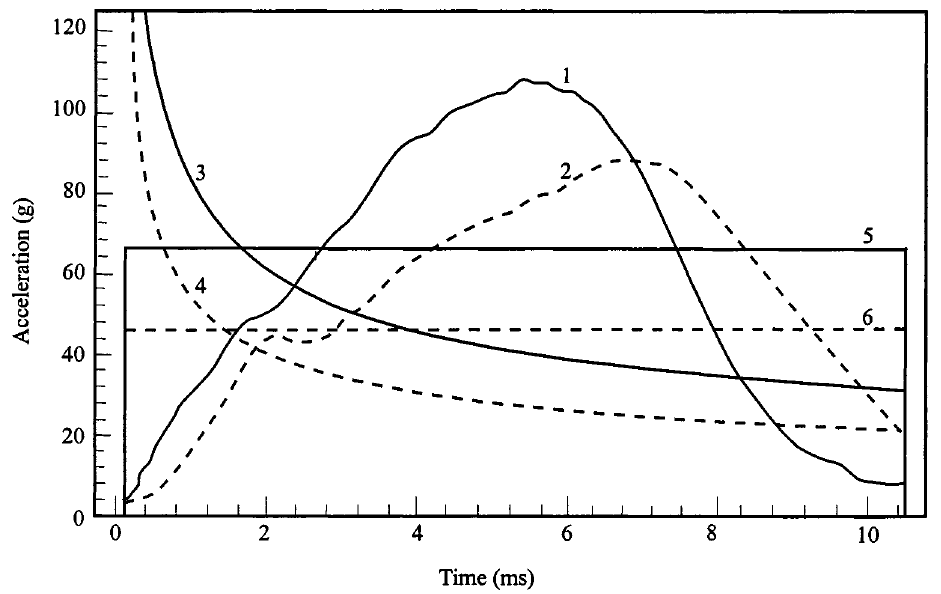
Fig. 8. Comparison of experimental and optimal acceleration. Curve 1: Test data, top impact; Curve 2: Test data, front impact; Curve 3: Minimiza- tion of HIC, S 0 = 17 : 5 mm; Curve 4: Minimization of HIC, S 0 = 26 : 0 mm; Curve 5: Minimization of peak head acceleration, S 0 = 17 : 5 mm; Curve 6: Minimization of peak head acceleration, S 0 = 26